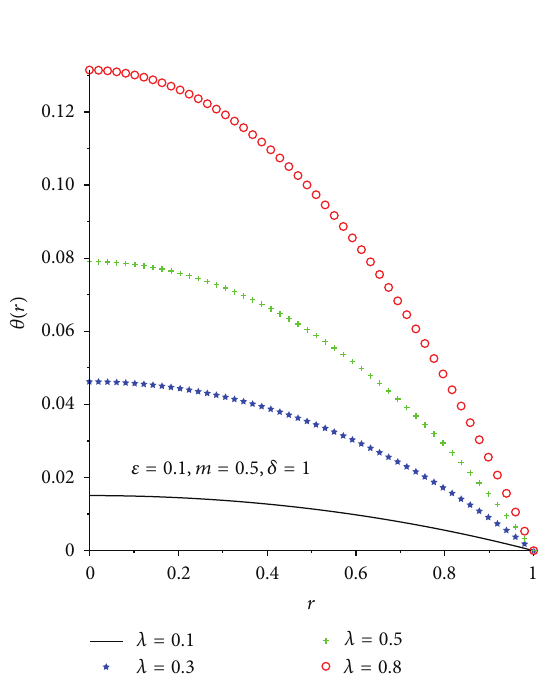
Figure 3: Temperature with 𝜆